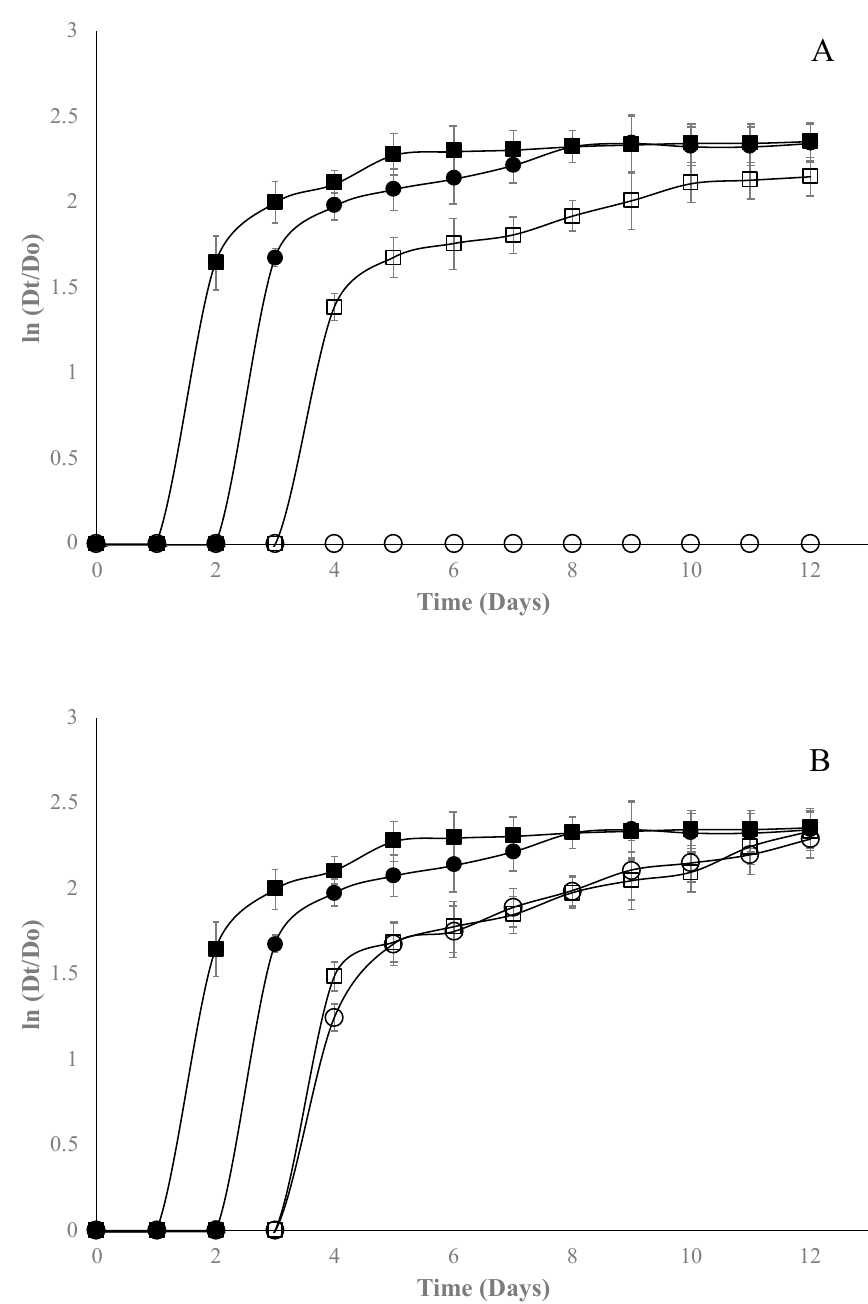
Figure 5. Effect of starch edible films added with selected concentrations of Mexican oregano ( Lippia berlandieri Schauer) essential oil (control [ (cid:4) ], 0% [ (cid:8) ], 1% [ (cid:3) ], and 2% [ ]) on Fusarium spp. growth with different nanocomposites, bentonite ( A ) or halloysite ( B ).